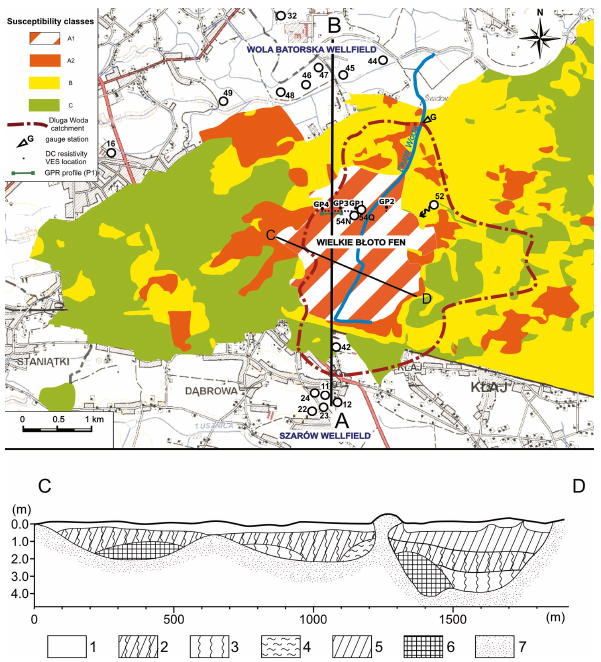
Figure 2. Upper panel: map of the study area showing the western part of Niepolomice Forest and Wielkie Błoto fen. GDTE suscepti- bility classes based on the depth to water table: A – very strongly de- pendent (0.0 to 0.5m); A1 – wetland ecosystem; A2 – forest ecosys- tem; B – strongly dependent (0.5 to 2.0m) forest ecosystem; C – weakly dependent (>2.0m) forest ecosystem. Lower panel: cross- section through Wielkie Błoto fen according Lipka (1989). 1 –